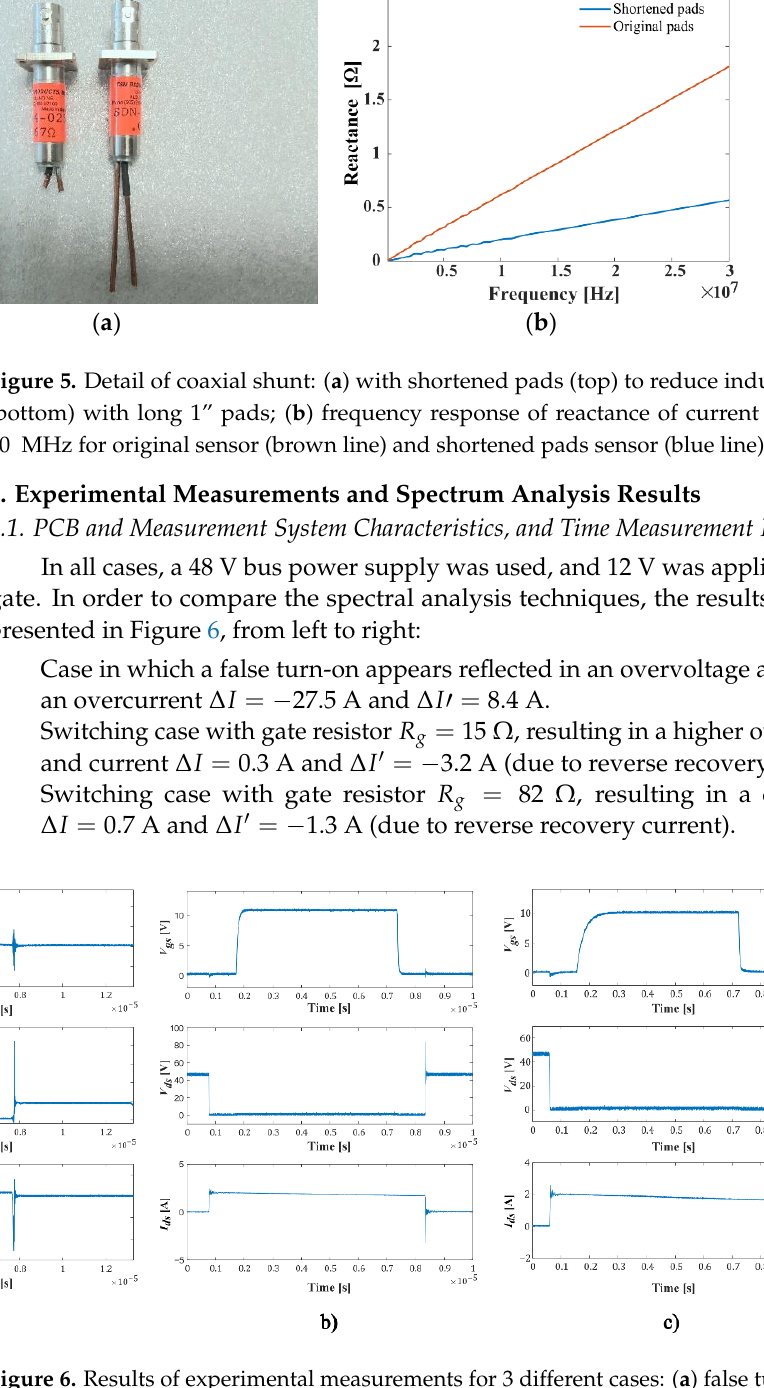
Figure 6. Results of experimental measurements for 3 different cases: ( a ) false turn-on; ( b ) switching with gate resistor 𝑅 𝑔 = 15 Ω ; ( c ) switching with gate resistor 𝑅 𝑔 = 82 Ω .